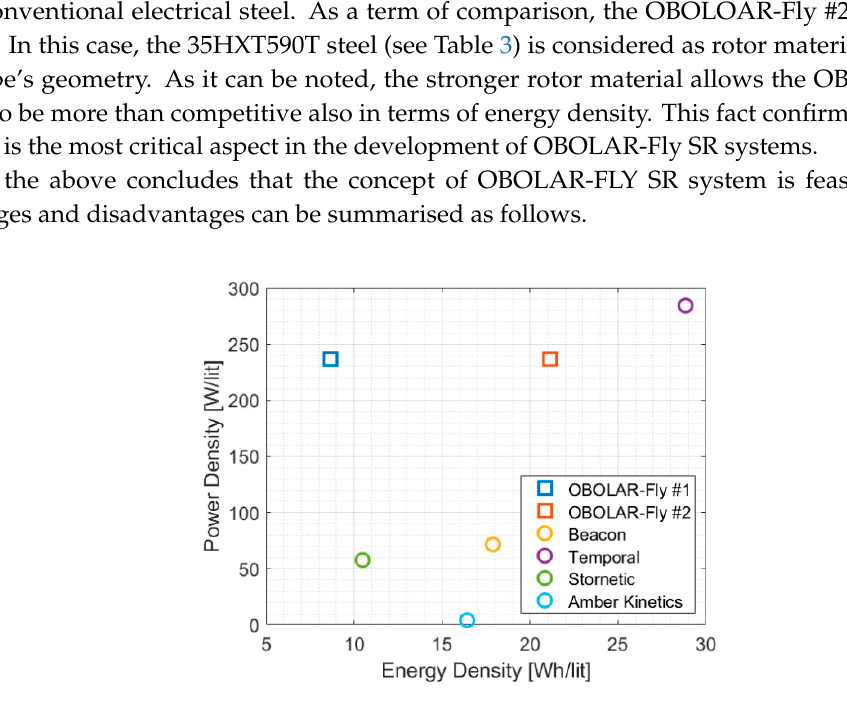
Figure 15. Comparison of power and energy densities (per unit of containment volume).